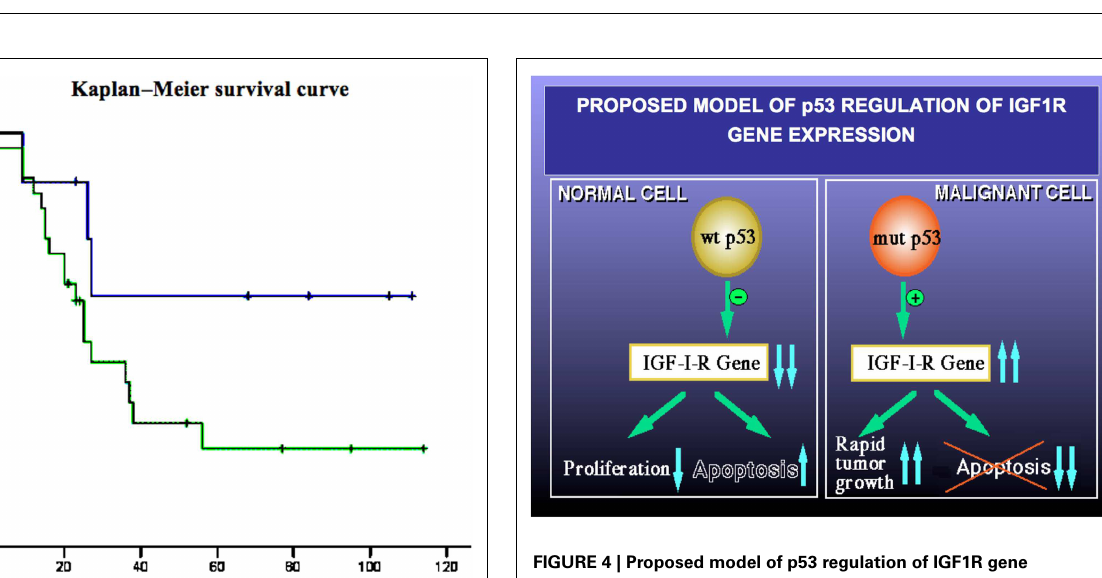
strong staining in all neoplastic cells (grade IV). BRCA1: (E) Primary tumor , neoplastic glands (arrows) adjacent to non-neoplastic endometrial glands (asterisks). H&E, × 200. (F) Primary tumor , moderate cytoplasmic staining in > 50% of cells in neoplastic and non-neoplastic glands. (G) Metastasis , moderate and strong cytoplasmic staining in nearly all neoplastic cells. (H) Metastasis , a focus of increased atypia, strong staining in all neoplastic cells. Immunohistochemistry data were shown in Ref. (23).